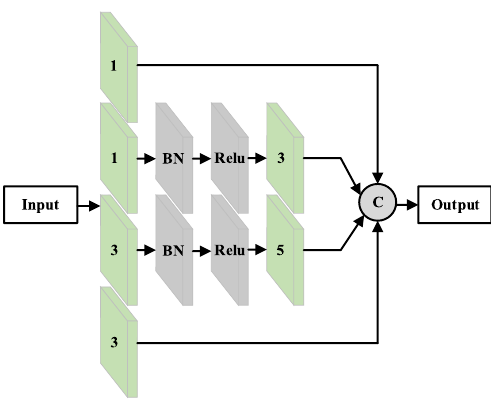
Figure 3. The structure of the Text-Inception